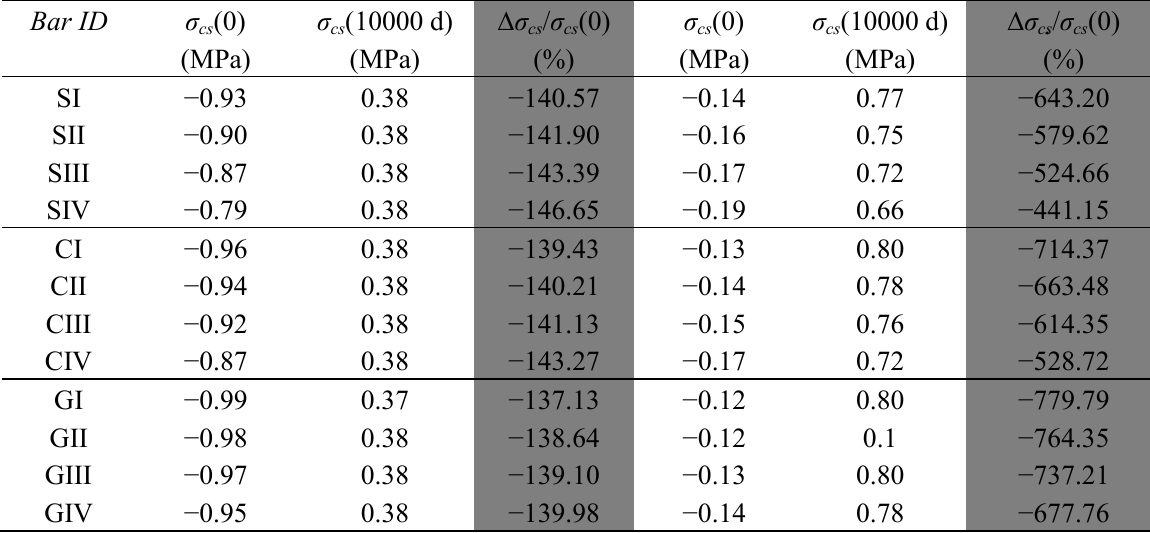
Table 4. Instantaneous stresses in the polymer